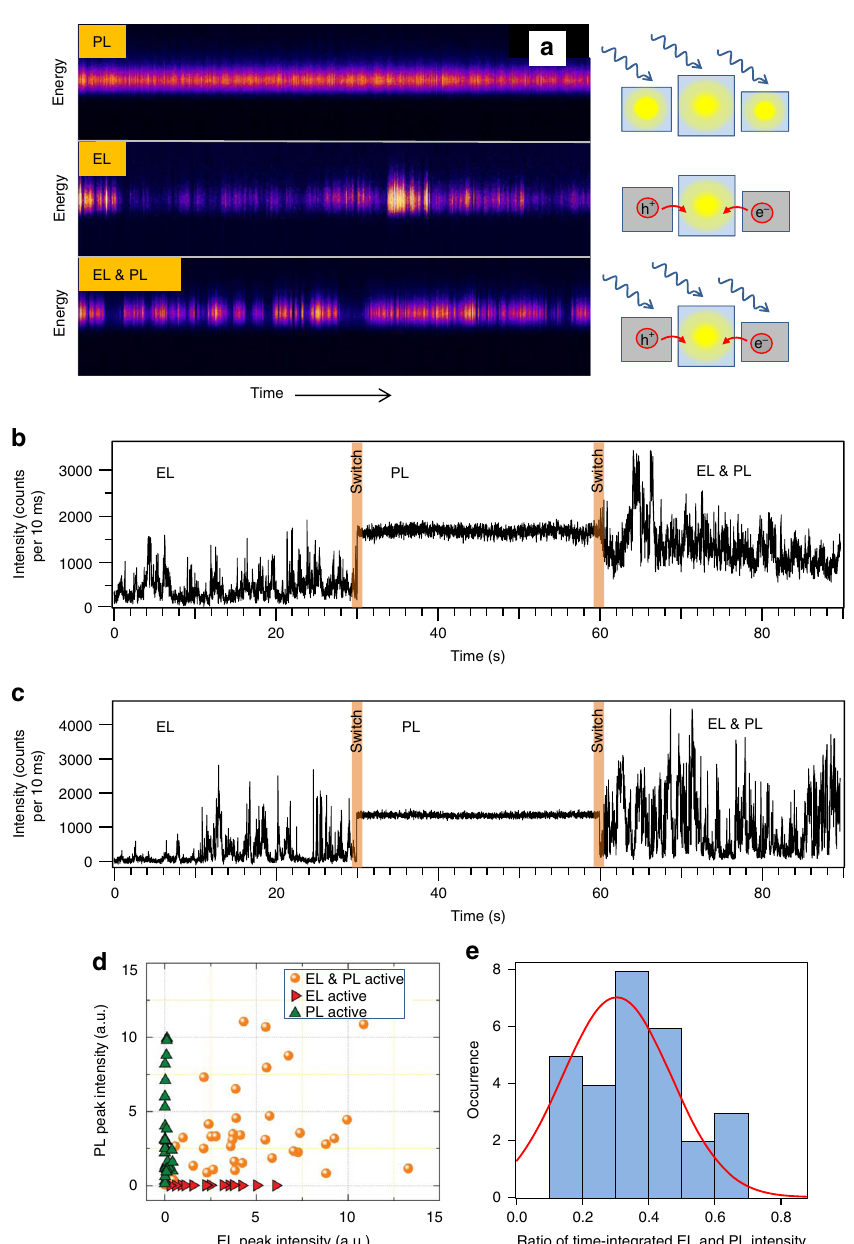
Fig. 4 Comparison of PL and EL characteristics. a Two-dimensional plots showing time evolution of emission spectra from an individual CsPbBr 3 NC aggregate, excited by light (top), charge recombination (middle), and combination of both (bottom). The scheme on the right explains the observations. b , c Time-traces of emission intensity obtained from two different single aggregates during switching of the excitation modes. PL was excited at 485 nm with 26 W cm − 2 , EL with bias of 14 V. d Correlation plot of 37 NCs that were active in both PL and EL (orange), in PL only (green), and in EL only (red). e Distribution of the ratio of EL and PL intensity, each integrated over the measurement time of 40